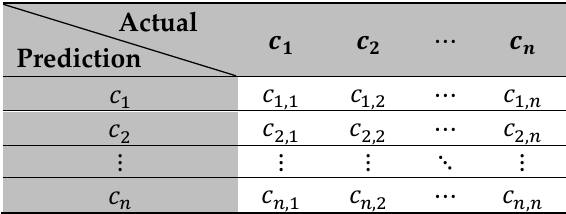
Table 1. Structure of confusion matrix for n classes.